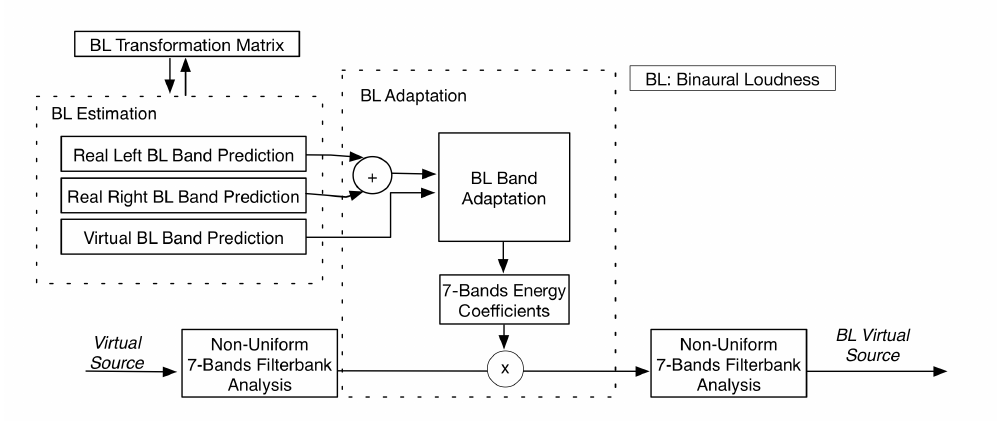
Figure 8. This figure presents the architecture of the binaural loudness band adaptation. The task of the BL adaptation algorithm is to estimate the BL difference between the same bands of the virtual and real components, as well as to calculate and apply the correlation coefficient of the BL difference of each band to the BL of all bands. The following functions present the methodology of the BL adaptation algorithm. 1. Estimation of the BL difference in each n frequency bands. The algorithm estimates the difference between the same band of the real and virtual components.